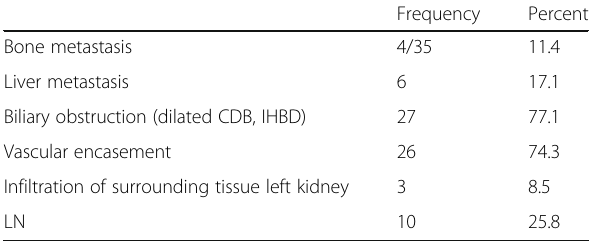
Table 3 The associated MRI findings of unresectable lesions